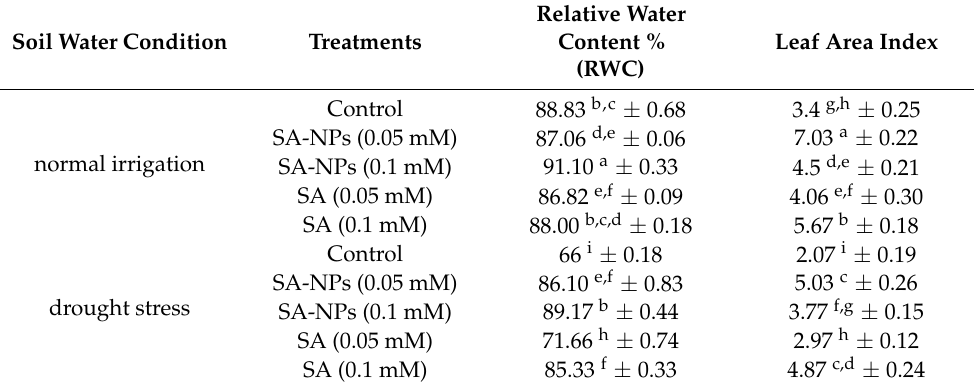
Table 4. Effect of drought stress, bulk SA, and SANPs on relative water content (RWC) and leaf area index (LAI).